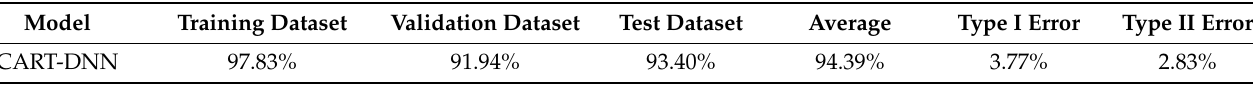
Table 4. Accuracy of the CART-DNN model.